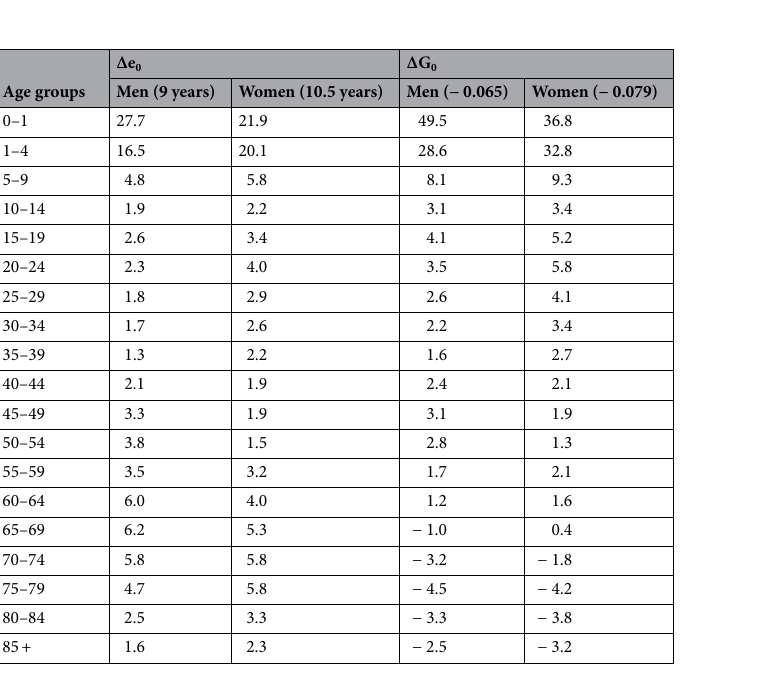
Table 1. Age-specific per cent contributions to Δe 0 and ΔG 0 , men and women, India, 1990–1994 and 2015– 2019. Source: Own calculations.